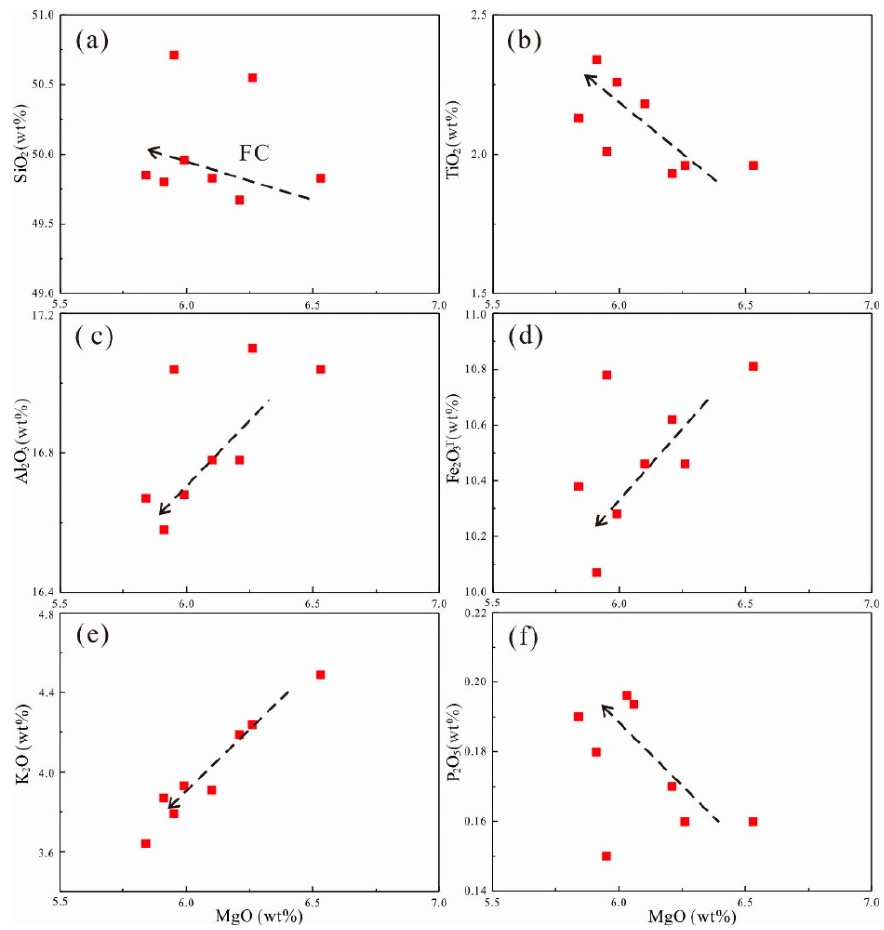
Figure 6. Harker diagrams showing the major element variations of the LTQ. FC—fractional crystallization. Fe 2 O 3T ( d ); Al 2 O 3 ( c ); and K 2 O ( e ) contents decrease, whereas SiO 2 ( a ); TiO 2 ( b ) and P 2 O 5 ( f ) contents increase with decreasing MgO contents.